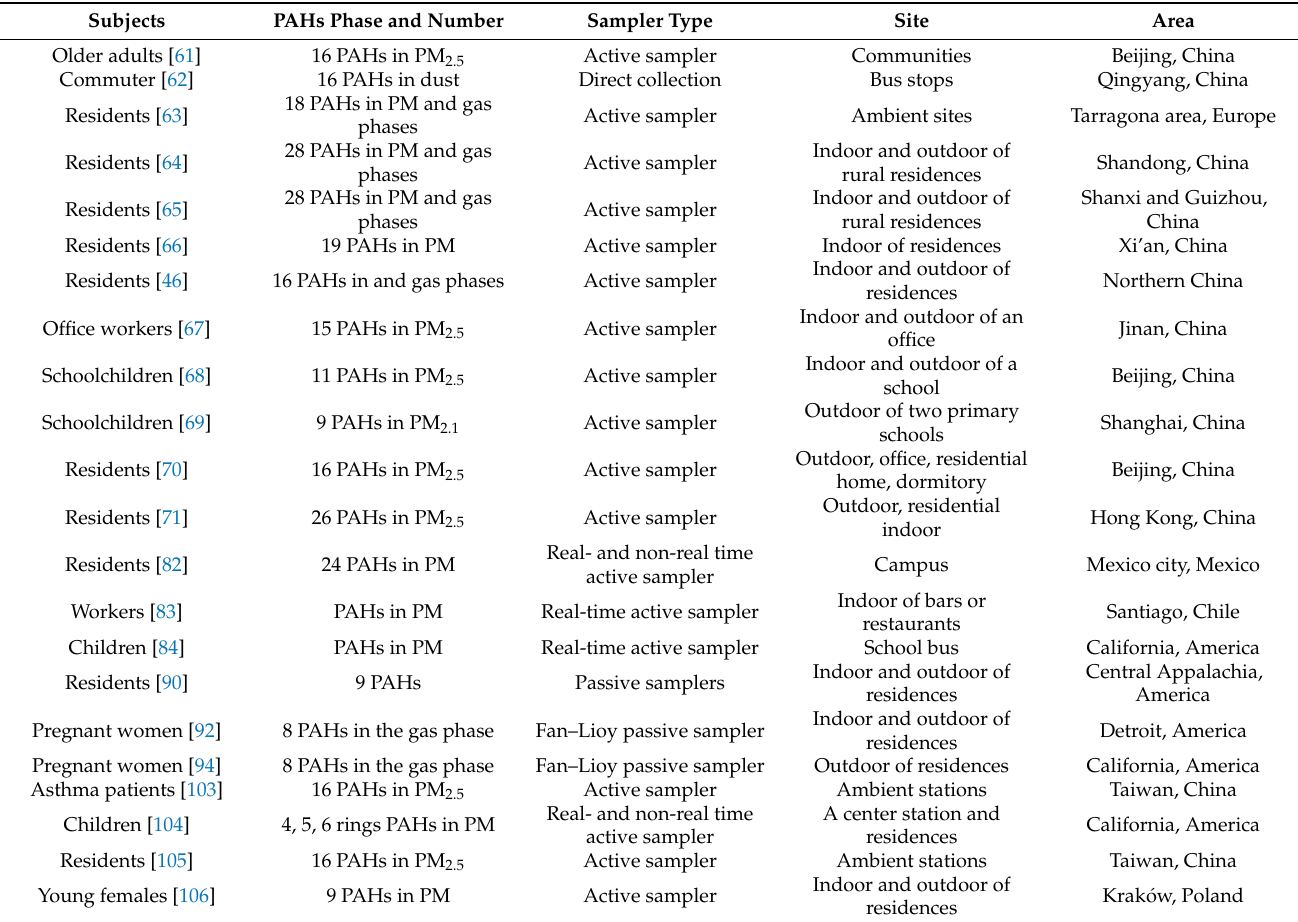
Table 1. Previous studies of PAH exposure measured by stationary sampling.